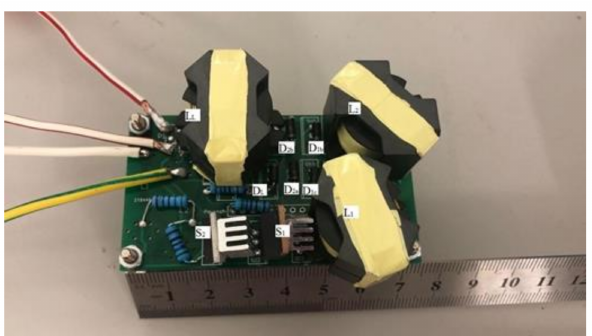
Figure 12. The prototype